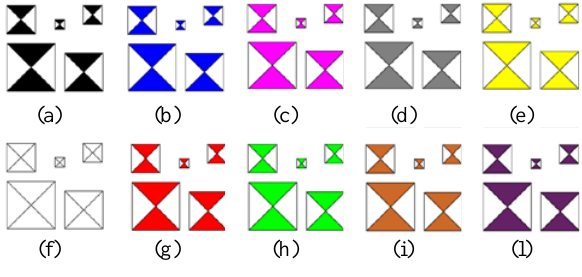
Figure 2. Several colours of cross-coded tested